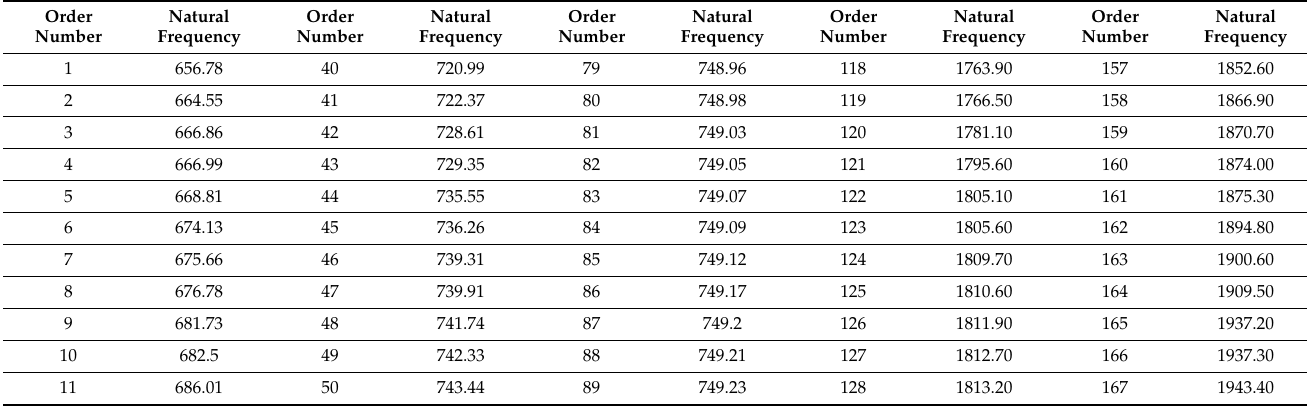
Table 8. First 195 order natural frequencies of a two-stage bladed disk coupled